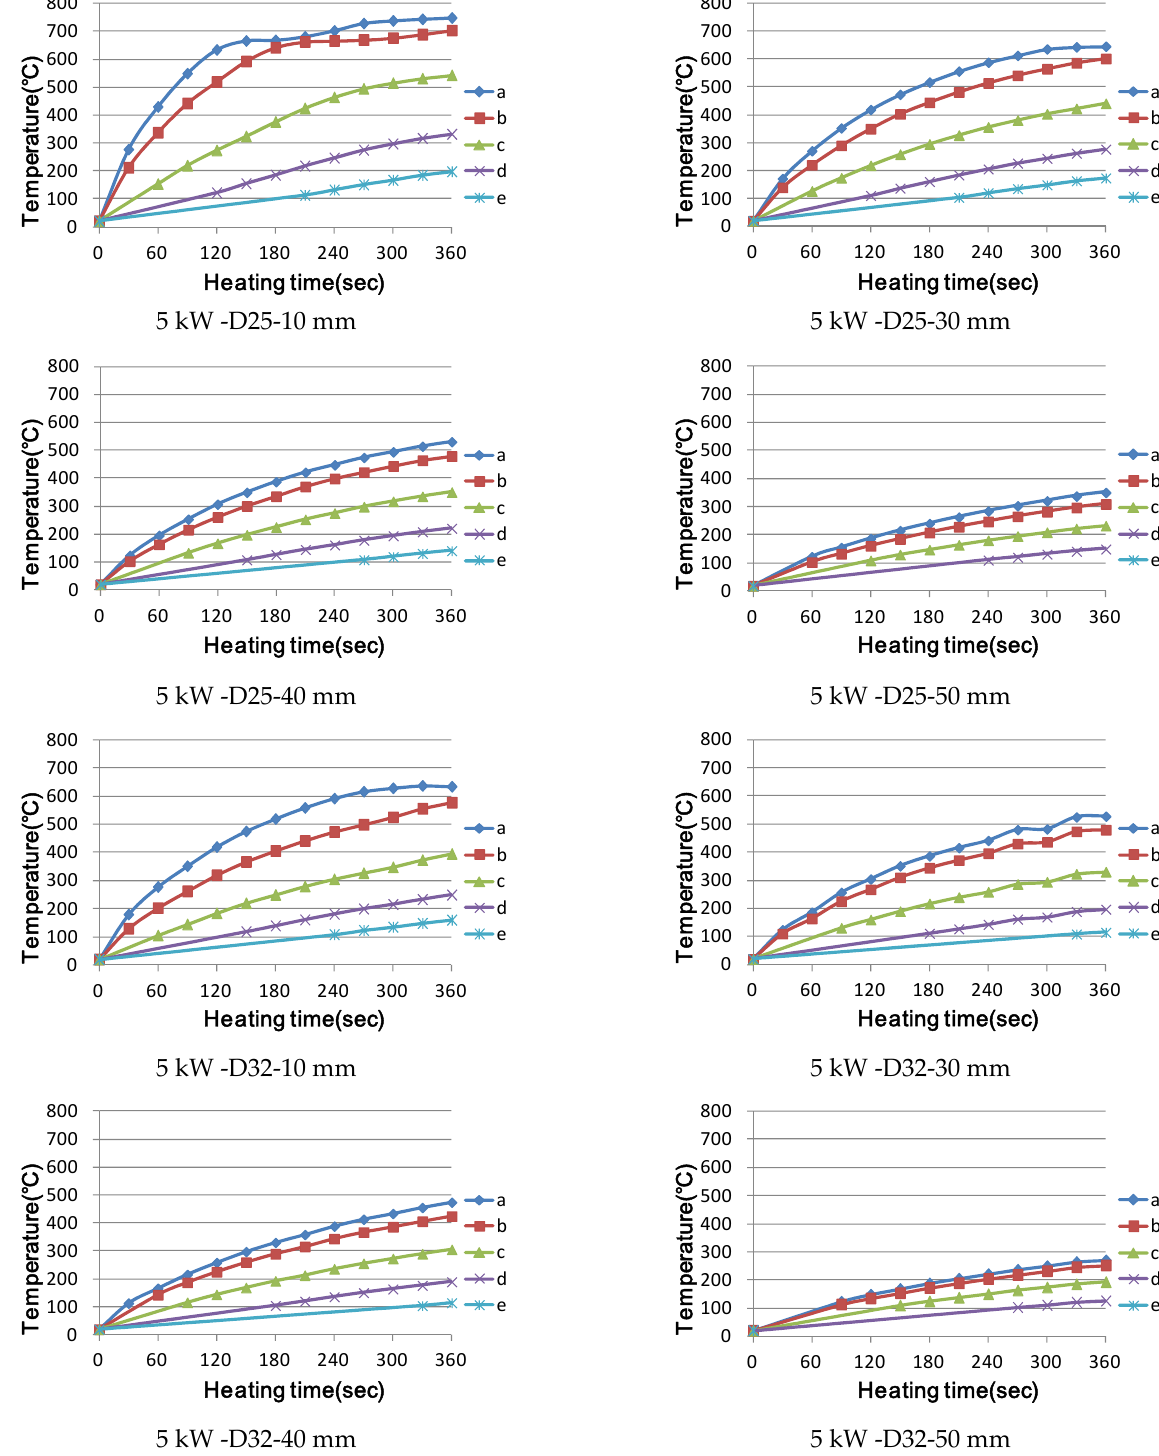
Figure 10. Rebar temperature distribution by induction heating (5KW-430mm). Rebar surface temperatures a, b, c, and d = 0 mm, 30 mm, 60 mm, and 90 mm from the center of reinforcement, respectively.